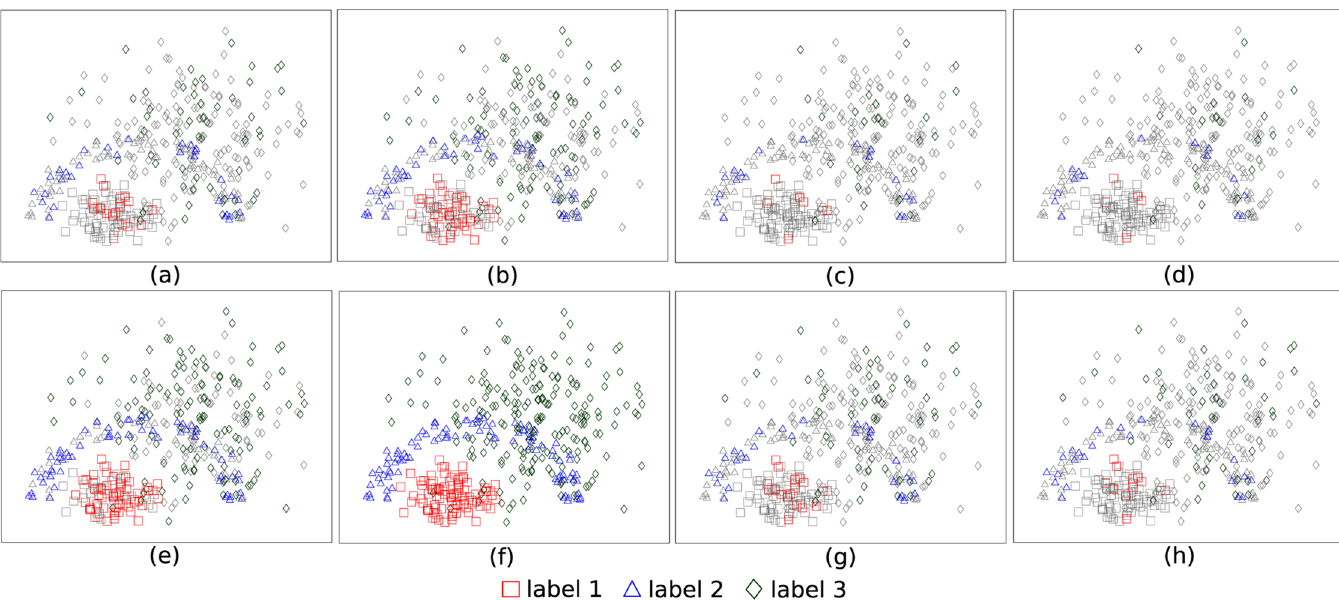
Fig 8. Randomly selected samples in the final training set when using the Cone-Torus dataset. (a) k -NN and 1 sec. (b) OPF and 1 sec. (c) LSVM and 1 sec. (d) KSVM and 1 sec. (e) k -NN and 1.5 sec. (f) OPF and 1.5 sec. (g) LSVM and 1.5 sec. (h) KSVM and 1.5 sec.